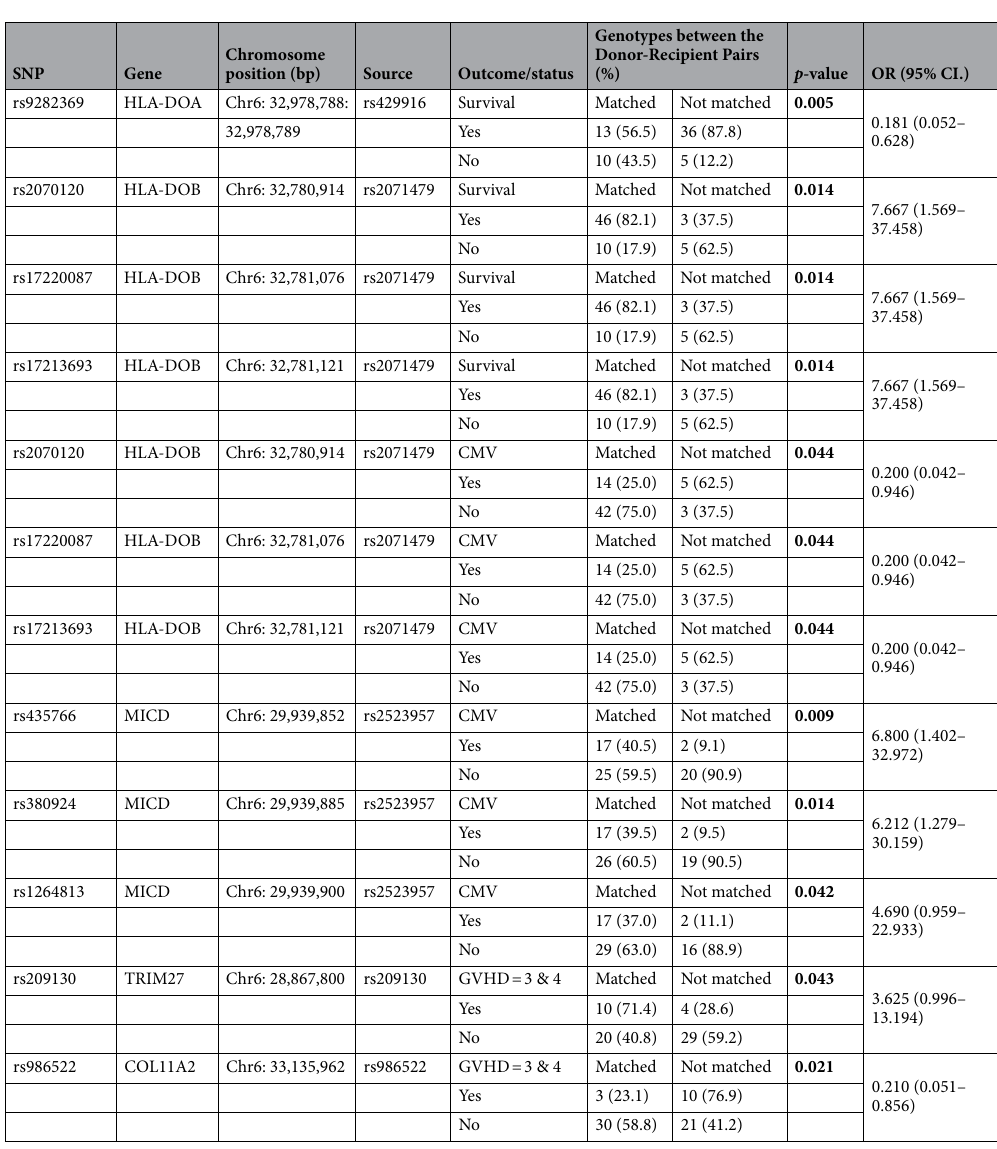
Table 6. The SNPs associated with the outcomes of unrelated CBT in donor-recipient pairs